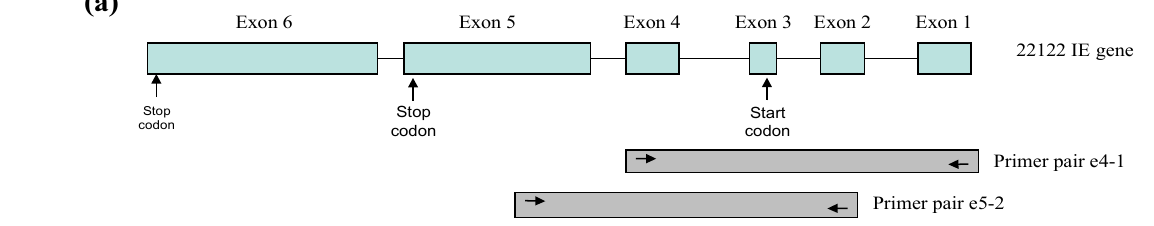
Figure 4. RT-PCR mapping of CIDMTR strain and 22122 strain splice sites. ( a ) Cartoon representation of the IE1/2 gene locus illustrating positions of primer pairs used for RT-PCR. Introns are indicated by straight lines and exons are blue boxes, although exon 1 and 2 are non-coding. ( b ) Results of RT-PCR reactions e4-1, e5-2, and GAPDH (control) using RNA from uninfected cells or cells infected with 22122 or CIDMTR. ( c ) RT-PCR consensus sequence of CIDMTR strain. Exon junctions are highlighted in blue. The first gray highlighted sequence is an ATA codon; this is an ATG codon and the putative start codon for the 22122 IE1/2 proteins, but is not conserved in the CIDMTR sequence in tissue culture passaged virus. The second gray highlighted sequence may therefore represent the putative start codon for CIDMTR TC